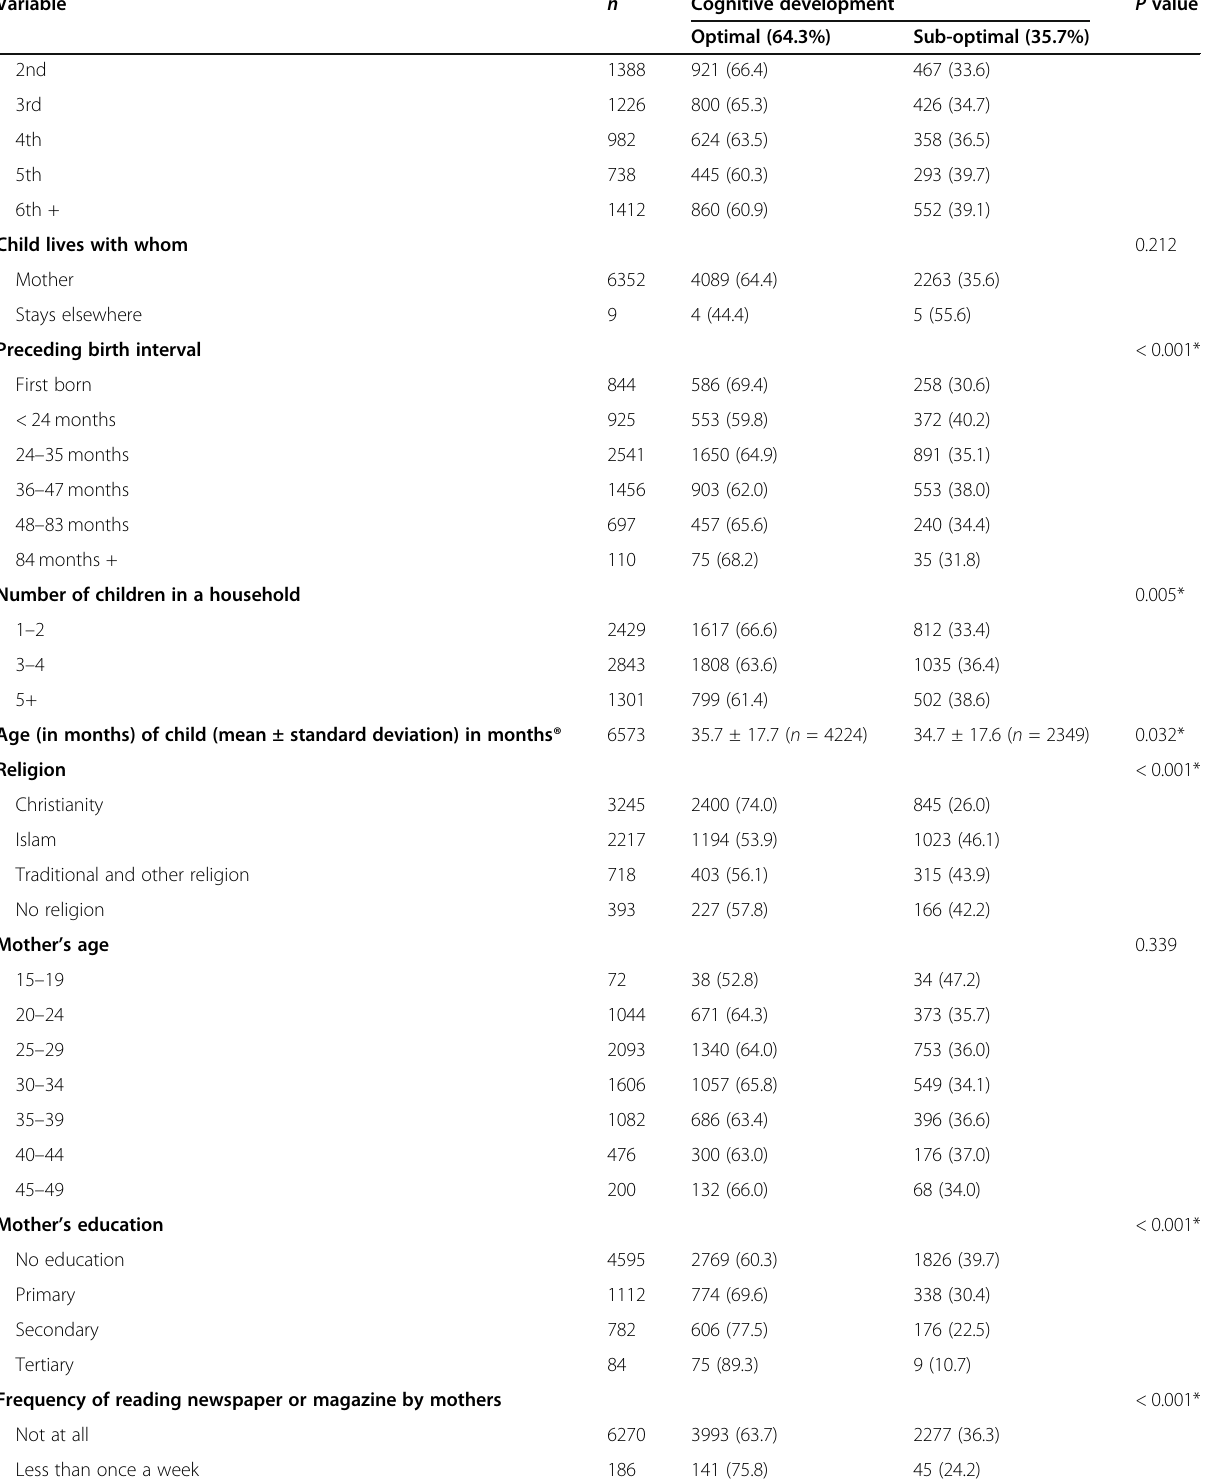
Table 1 The factors associated with under-five cognitive development using Chi-square test (Continued)